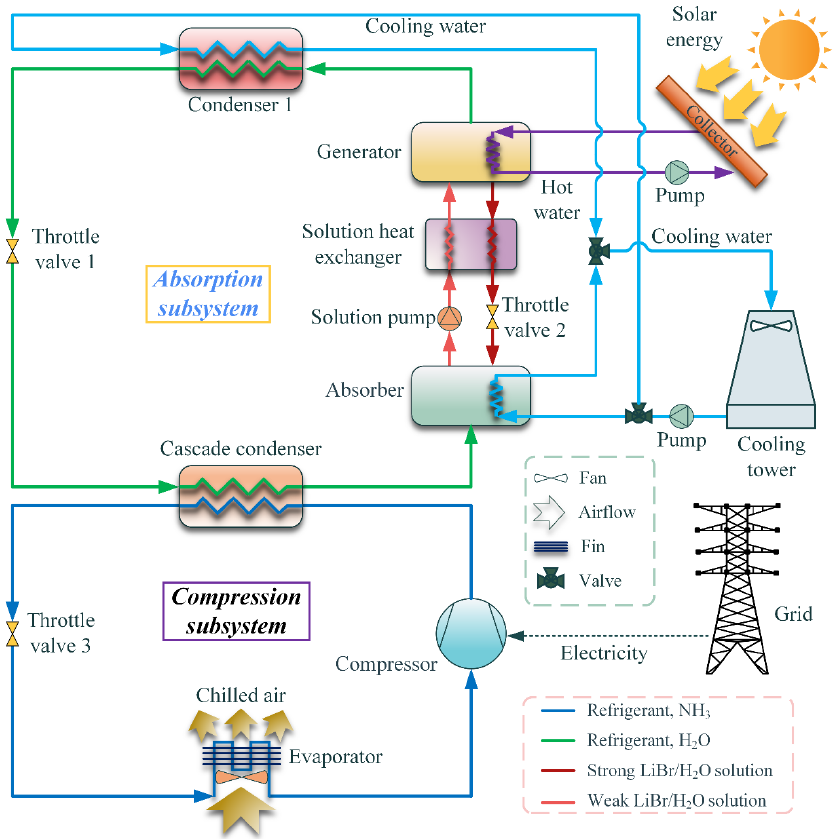
Figure 2. Schematic diagram of solar-assisted hybrid cooling system with cascade condensation pro- cess.